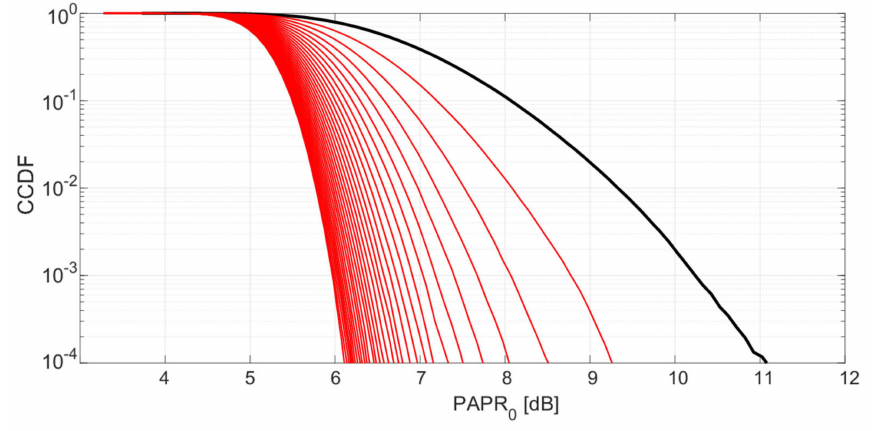
Figure 4. Comparisons of CCDF in OFDM-APSK system for conventional OFDM (black) and for the random SLM PAPR reduction technique with U ranging from 2 to 32, step 1 (red, from right to left).